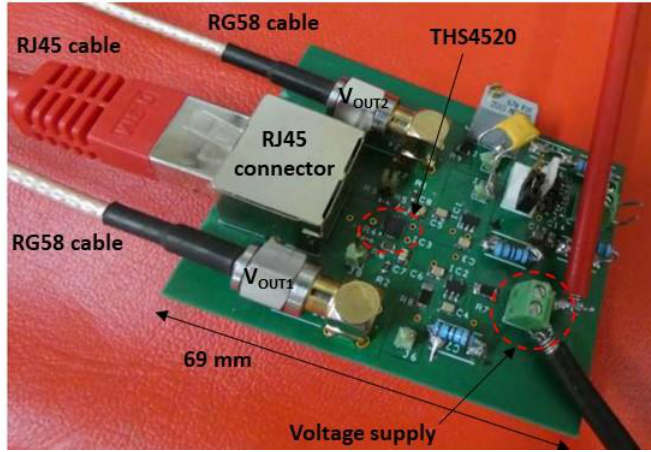
Figure 21. View of the printed circuit board of the conditioning circuit.